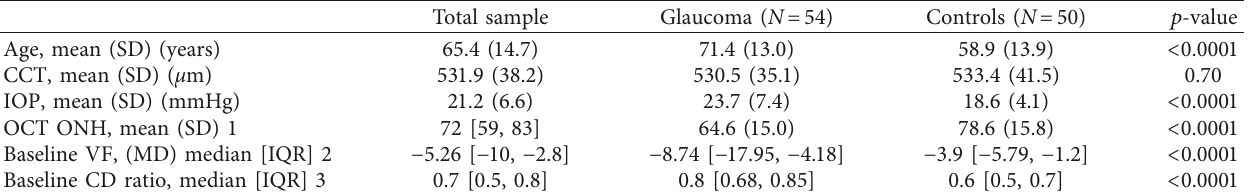
Table 3: Demographics in glaucoma vs. control participants ( N � 104).